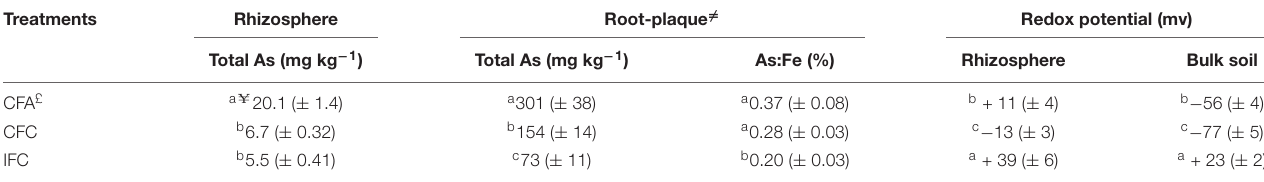
TABLE 1 | Total As-concentrations and redox potential in the rhizosphere and root-plaque samples under the experimental treatments. Treatments